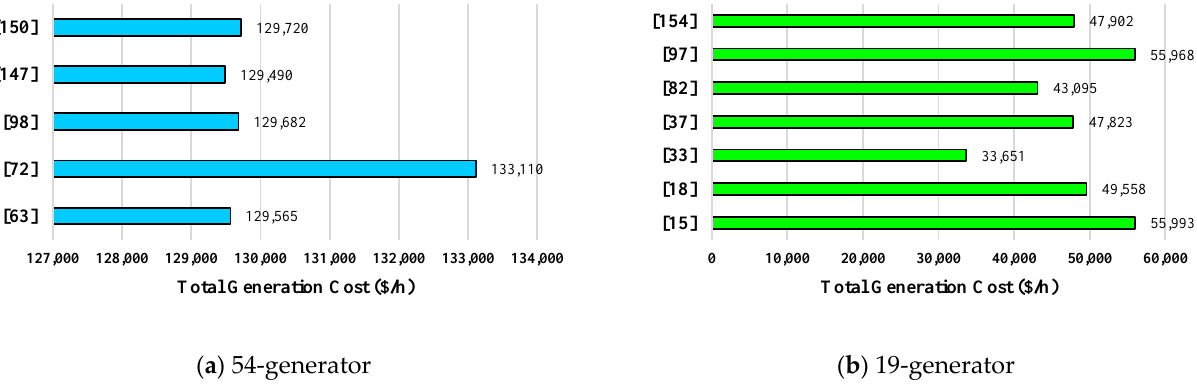
Figure 11. Comparison of cost obtained by different algorithms for IEEE 118-bus test system based on objective function (6): ( a ) 54-unit test system, ( b ) 19-unit test system.